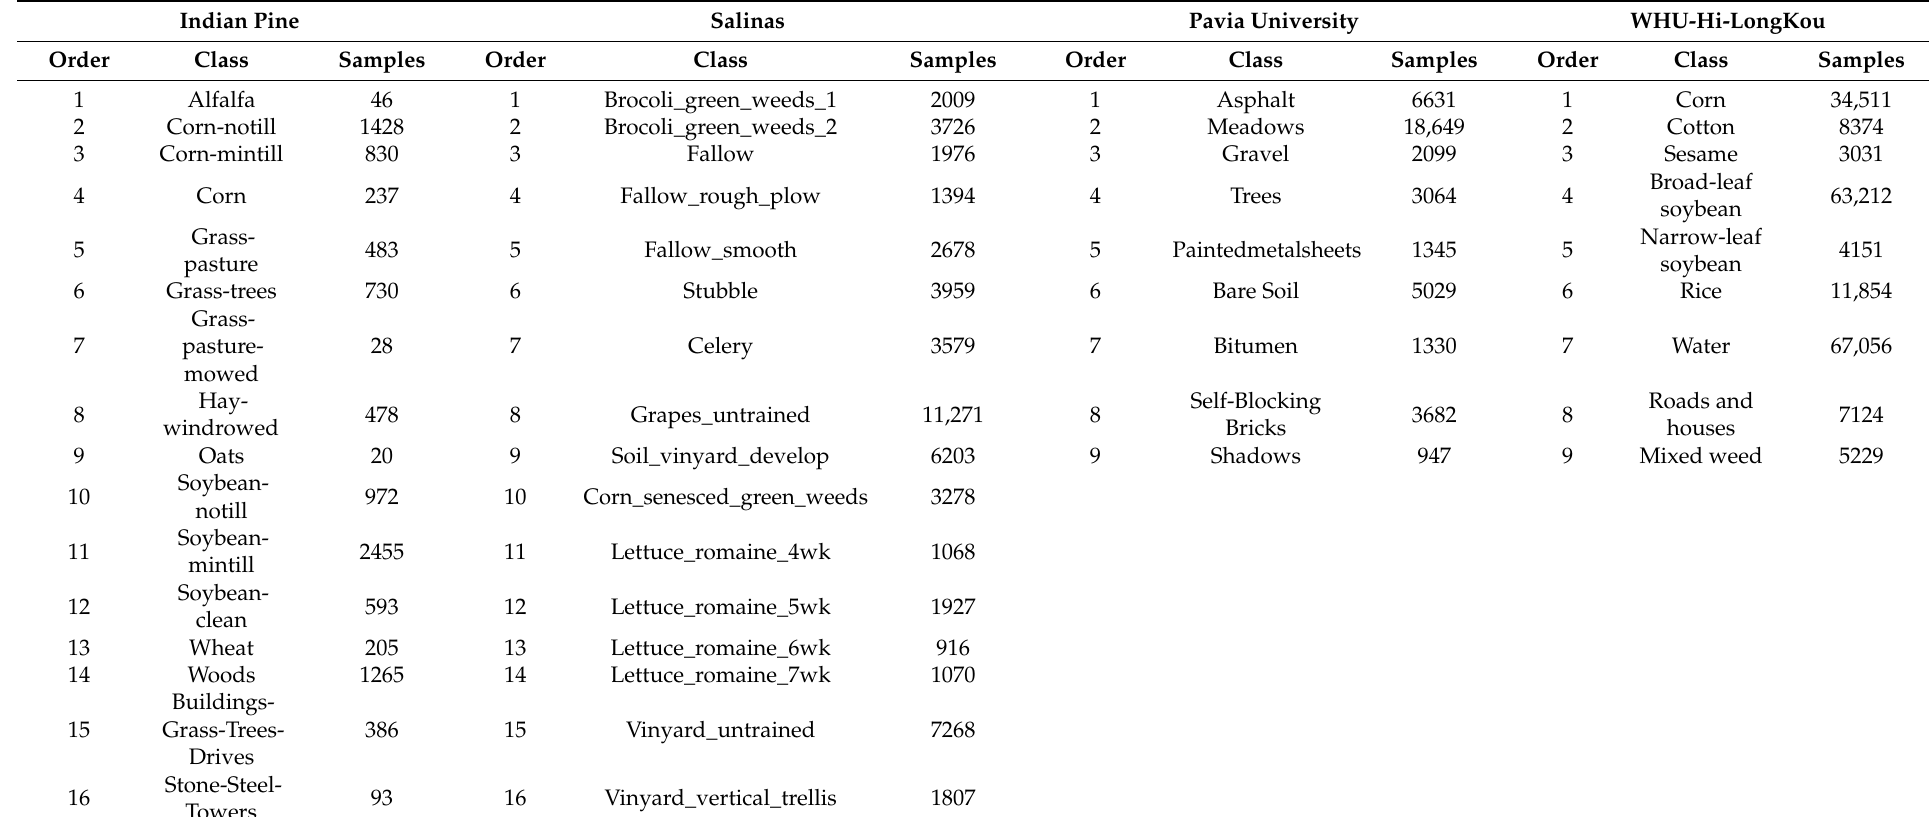
Table 1. Ground truth classes for all datasets and their respective sample